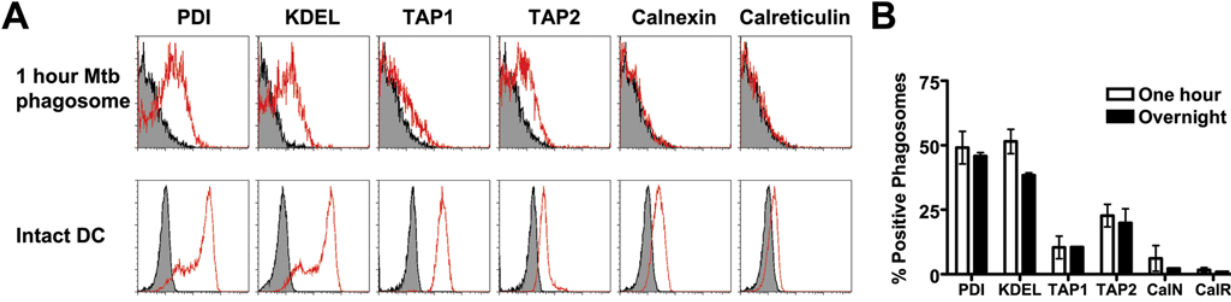
Figure 4. The Mtb phagosome contains HLA-I loading accessory molecules. (A) DC were pulsed with H37Rv-eGFP for 20 minutes, washed, and incubated for 40 minutes. Phagosomal fractions were prepared as in Figure 3 and stained with the indicated antibodies (top panel). Intact DC were fixed, permeabilized, and stained with the indicated antibodies (bottom panel). Data are representative of three experiments. (B) Quantitative analysis of Mtb phagosomes over time. The percent positive number represents Overton cumulative histogram subtraction of the isotype control from the indicated stain. Each bar represents the mean 6 SEM from three experiments per timepoint.